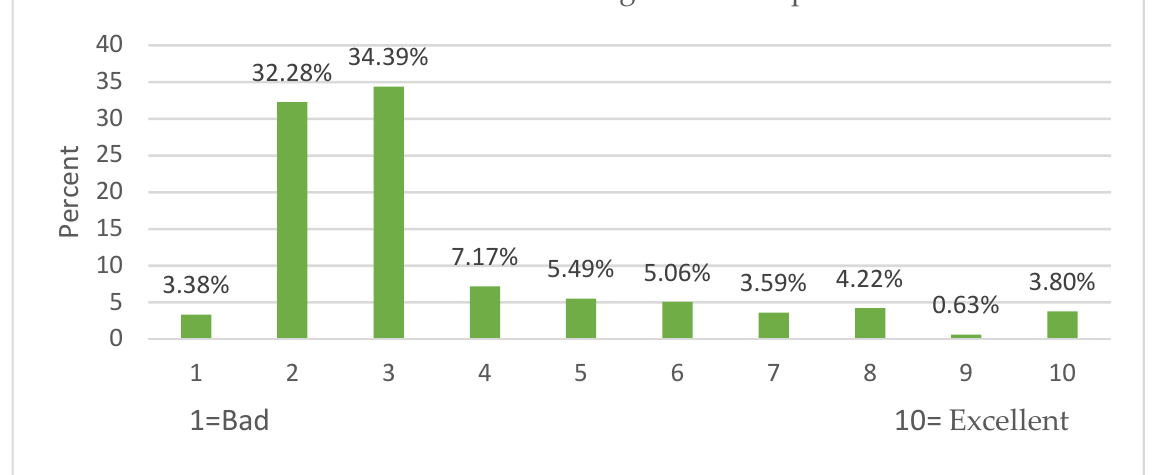
Figure 3. Average number of hours you spent online during a lockdown .